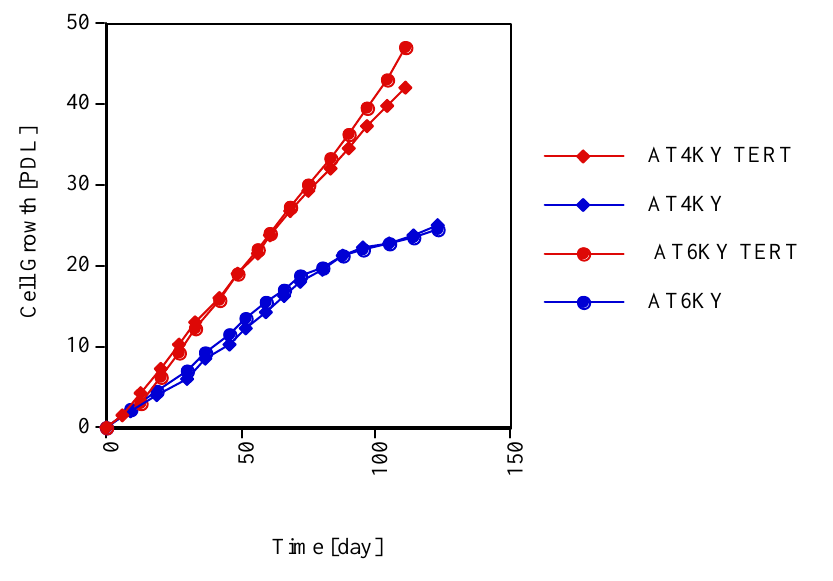
Fig. 1. Growth curves of AT and normal fibroblasts in the presence or absence of hTERT